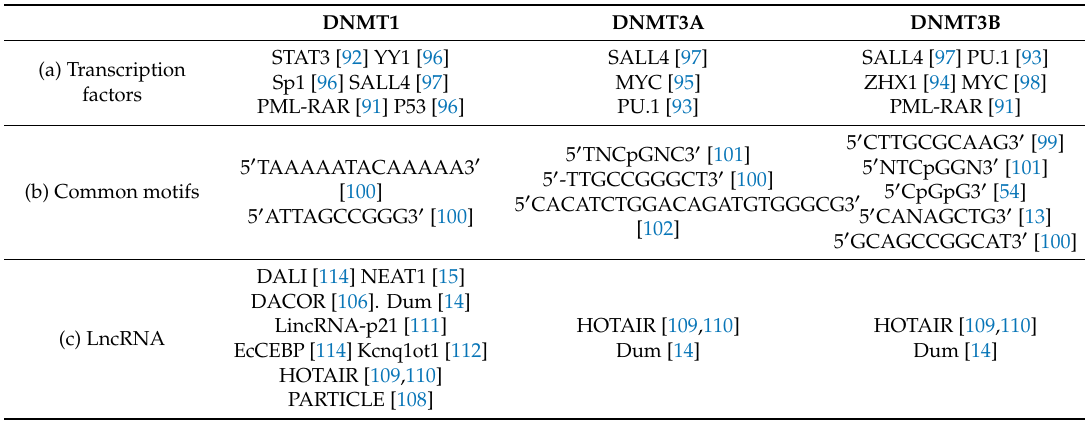
Table 1. Elements that favors the interaction and specific targeting for